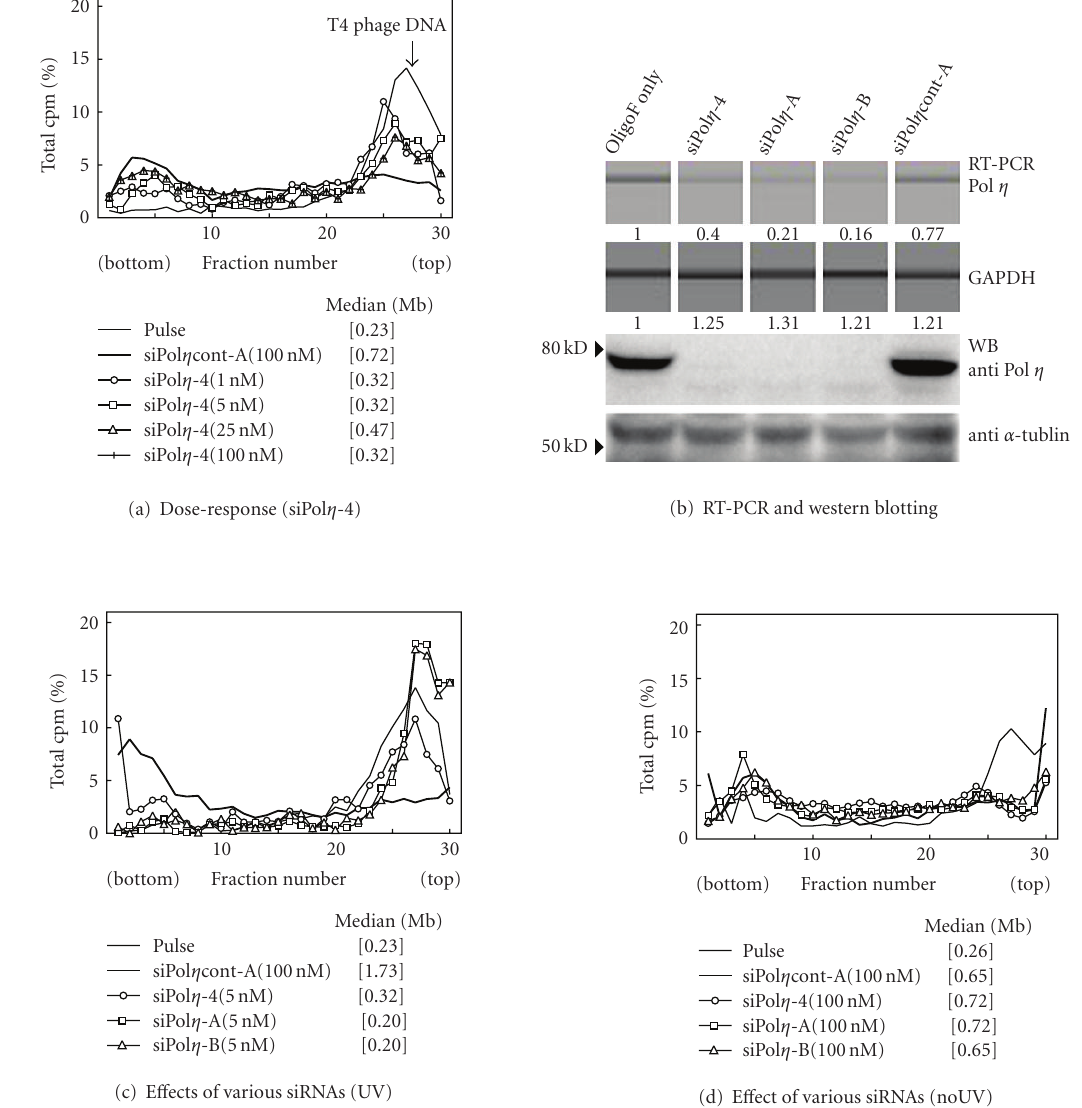
Figure 4: E ffi cient knockdown by Pol η siRNAs and the e ff ects on UV-induced TLS in HeLa cells (ASDG profiles of replication products). (a) Dose-response of siPol η -4 on UV-TLS, E ffi ciency of knockdown on Pol η expression; (b) RT-PCR analysis and western blot analysis, (c) E ff ects of various Pol η siRNAs on UV-TLS, (d) E ff ect of various Pol η siRNAs (no UV control). Twenty-four hours after Pol η siRNA transfection, total RNA was isolated and Pol η RNA was quantified by RT-PCR. Results were shown in MultiNA gel images and the expression level was presented under the panel (b). Forty hours after Pol η siRNA transfection, whole cell extracts were prepared and Pol η protein was quantified by western blot analysis (b). Forty hours after Pol η siRNA transfection, cells were UV-irradiated (10J/m 2 ), incubated in normal medium for 30 minutes, pulse-labelled with 10 μ Ci/mL of [ 14 C]thymidine for 1 hour, then washed twice with PBS, and incubated